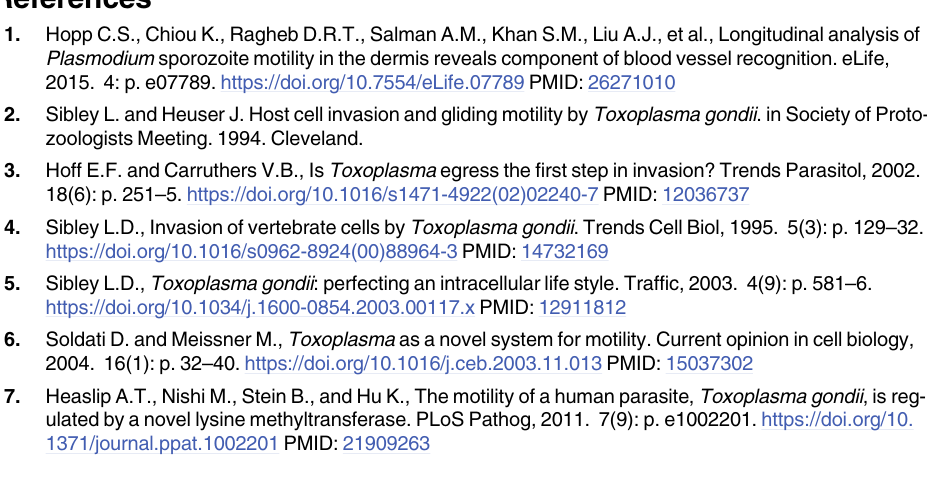
S3 Table. Raw data for graphs in Fig 5A, Fig 6D, Fig 7C, and Fig 10D.